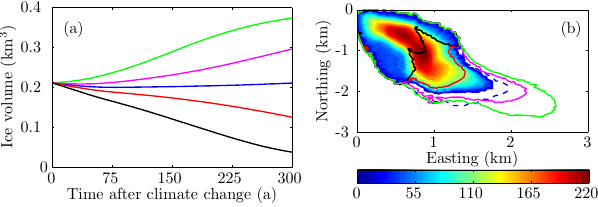
Fig. 10. Climate sensitivity of Haig Glacier. (a) Evolution of ice volume under various mass balance (step-change) scenarios: 1b n = + 1000 (green), + 900 (magenta), + 800 (red), + 700 (black) mmw.e.a − 1 . The blue line depicts the equilibrium climatic thresh- old 1b n0 ≈ + 850mmw . e . a − 1 . (b) Areal extents of glacier after 300yr of simulations. Distribution of ice thickness (m) for 1b n0 is also shown. Match the color codes to identify the glacier outlines for other climatic scenarios. The dotted blue line shows the present-day glacier